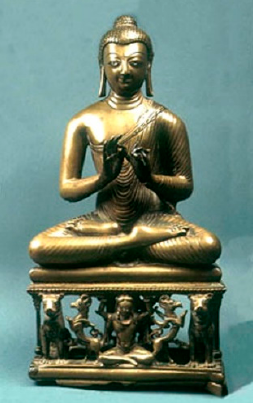
Figure 31. Vairocana Buddha performing the dharmacakra-pravartana mudr ā . circa 725–750. India, Jammu and Kashmir, Kashmir region, South Asia. Brass inlaid with silver. 16 × 8 1/2 × 3 5/8 in. (40.64 × 21.59 × 9.2 cm). Nasli and Alice Heeramaneck Collection (M.69.13.5). LACMA. https://collections.lacma.org/node/236668.